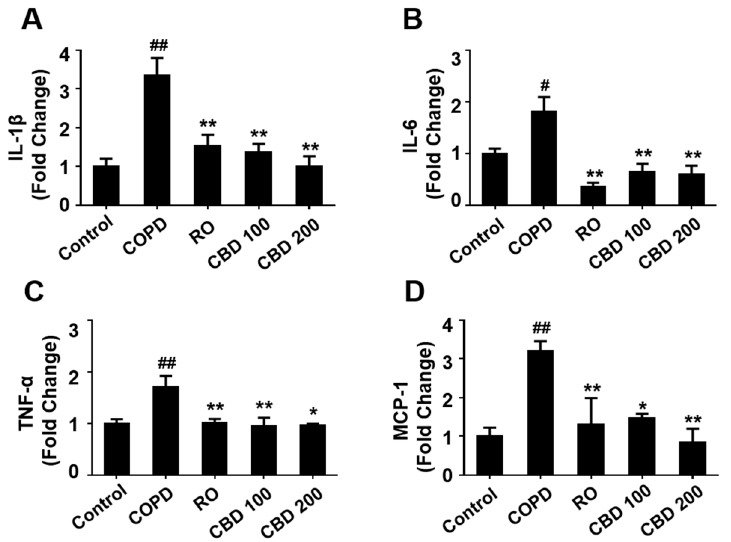
Figure 4. Analysis of mRNA levels of inflammatory cytokines in lung tissues. Expression of ( A ) IL-1 β , ( B ) IL-6, ( C ) TNF- α , and ( D ) MCP-1 mRNAs was measured by RT-PCR. Control: mice instilled intratracheally with normal saline; COPD: mice exposed to CS and LPS; RO: mice exposed to 10 mg/kg roflumilast plus CS and LPS; CBD 100: mice exposed to 100 mg/kg CBD plus CS and LPS; CBD 200: mice exposed to 200 mg/kg CBD plus CS and LPS. Results are presented as means ± SEMs. # p < 0.05, ## p < 0.01 compared with the control group; * p < 0.05, ** p < 0.01 compared with the COPD